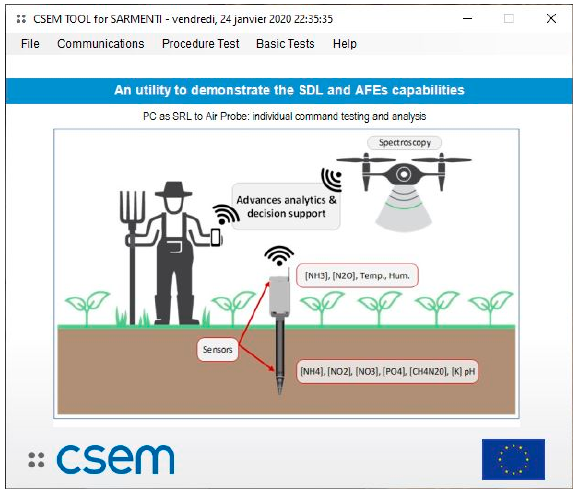
Figure 22. Smart Data Logger PCTool main screen.